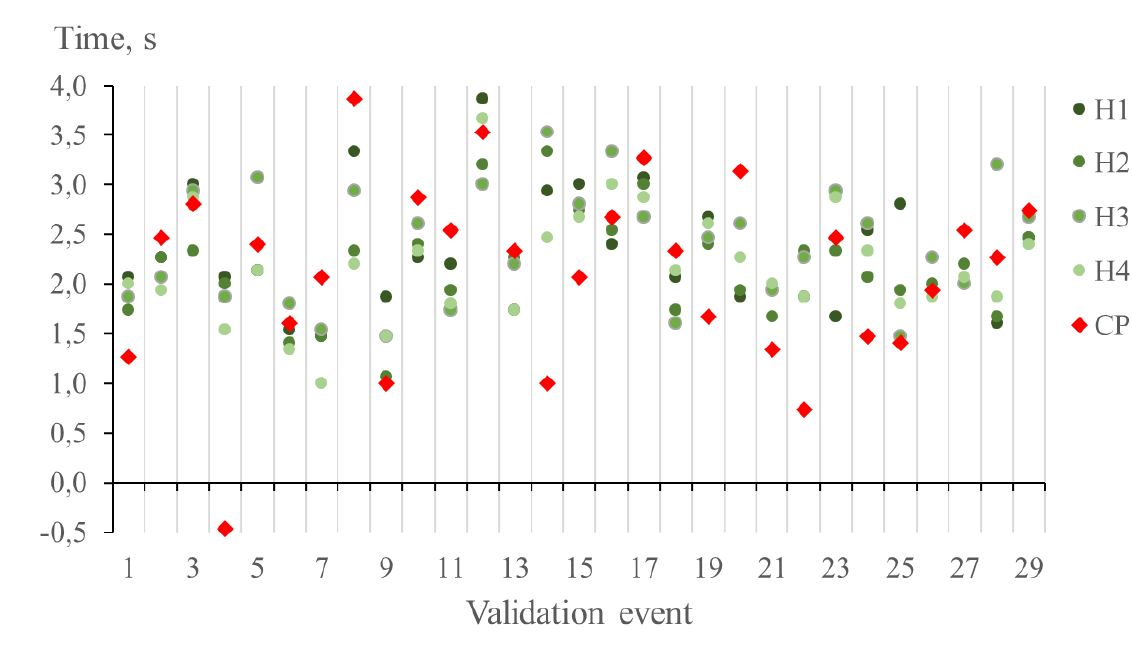
Figure 9 Detection of evasive action by the human observers (H1 – 4, green) and the computer algo- rithm (CP, red): validation